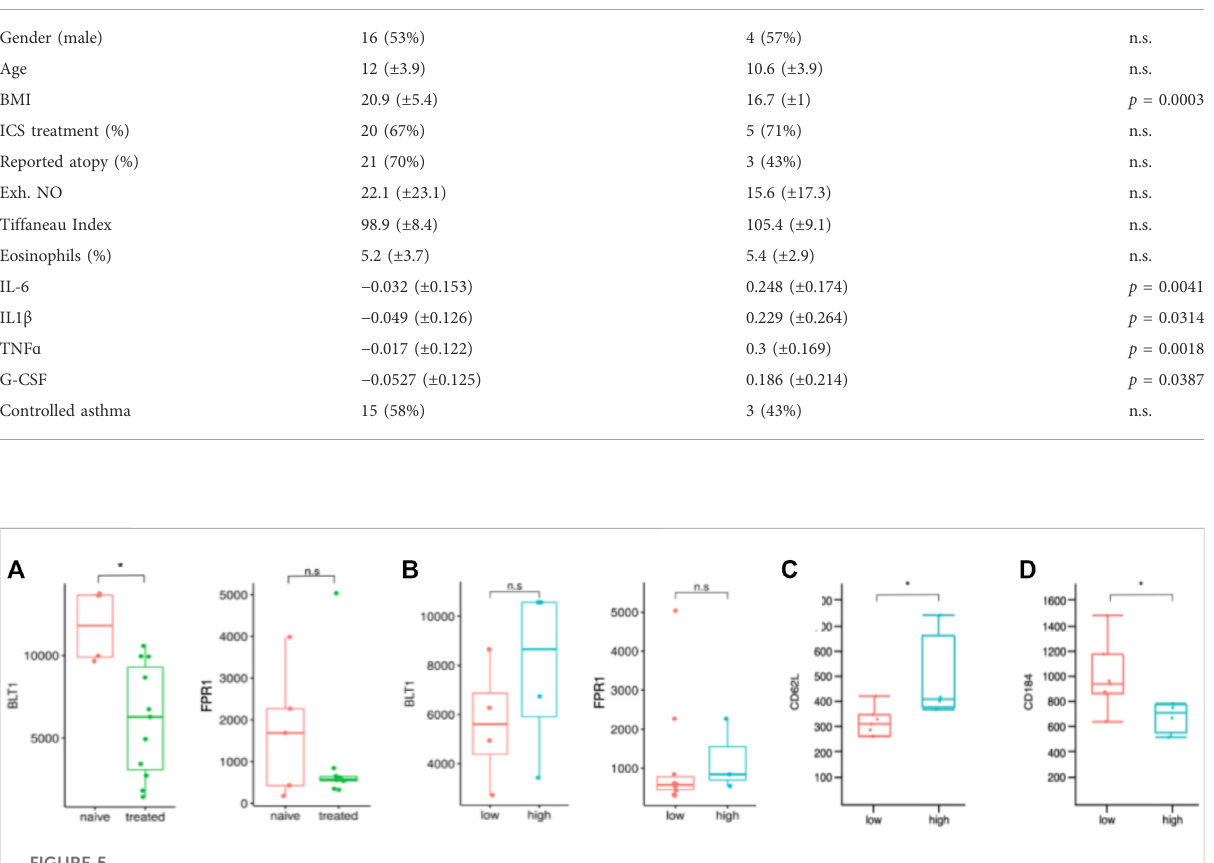
FIGURE 5 Surface receptor expressions of asthmatic patients could explain the altered migration behavior. (A) Comparison of BLT1 and FPR1 expression on neutrophils of corticosteroid naive and treated patients. Fluorescence units arbitrary on y-axis; BLT1: n = 4 naive and n = 10 treated. FPR1: n = 5 naive and n = 7 treated. n.s. not signi fi cant, * p < 0.05, Wilcoxon. (B) Comparison of BLT1 and FPR1 expression on neutrophils of patients with Th1 high and low pro fi les. No signi fi cant difference was detected. Fluorescence units arbitrary on y-axis; BLT1: n = 4 low and n = 4 high. FPR1: n = 8 low and n = 3 high. n.s., not signi fi cant. Comparison of CD62L (C) and CD184 (D) expression on neutrophils of patients with Th1 high and low pro fi les. Fluorescence units arbitrary on y-axis; CD62L: n = 4 high and n = 8 low. CD184: n = 4 high and n = 7 low. * p < 0.05,